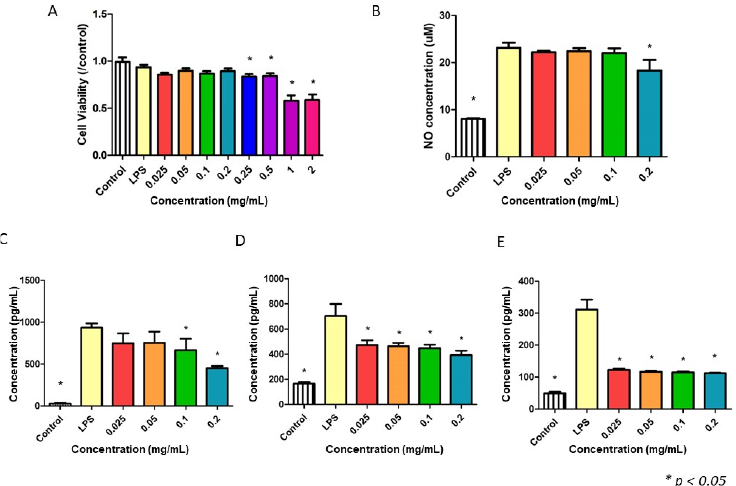
Figure 9. The effects of NF3 on RAW 264.7. Different doses of NF3 (0.25–2 mg/mL) were added to macrophage cultivation. RAW 264.7 was activated by 1 µg/mL LPS. ( A ) MTT. The data showed that a high dose of NF3 (0.25–2 mg/mL) reduced cell viability in RAW 264.7 ( p < 0.05). ( B ) Nitric oxide (NO) inhibitory assay. The level of NO was suppressed when 0.2 mg/mL NF3 was supplied ( p < 0.05). ( C – E ) ELISA results of IL-6, MCP-1, and TNF- α , respectively. NF3 (0.025–0.2 mg/mL) reduced the levels of pro-inflammatory cytokines in the supernatant of LPS-activated macrophages ( p < 0.05).